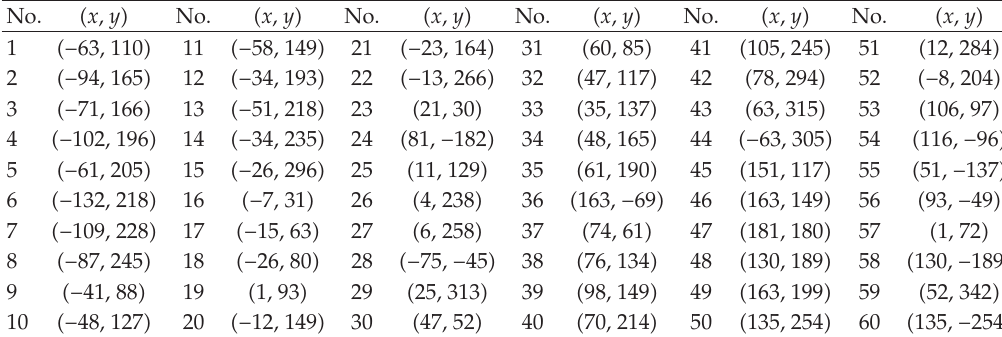
Table 2: Coordinates of the points in Q under reflection